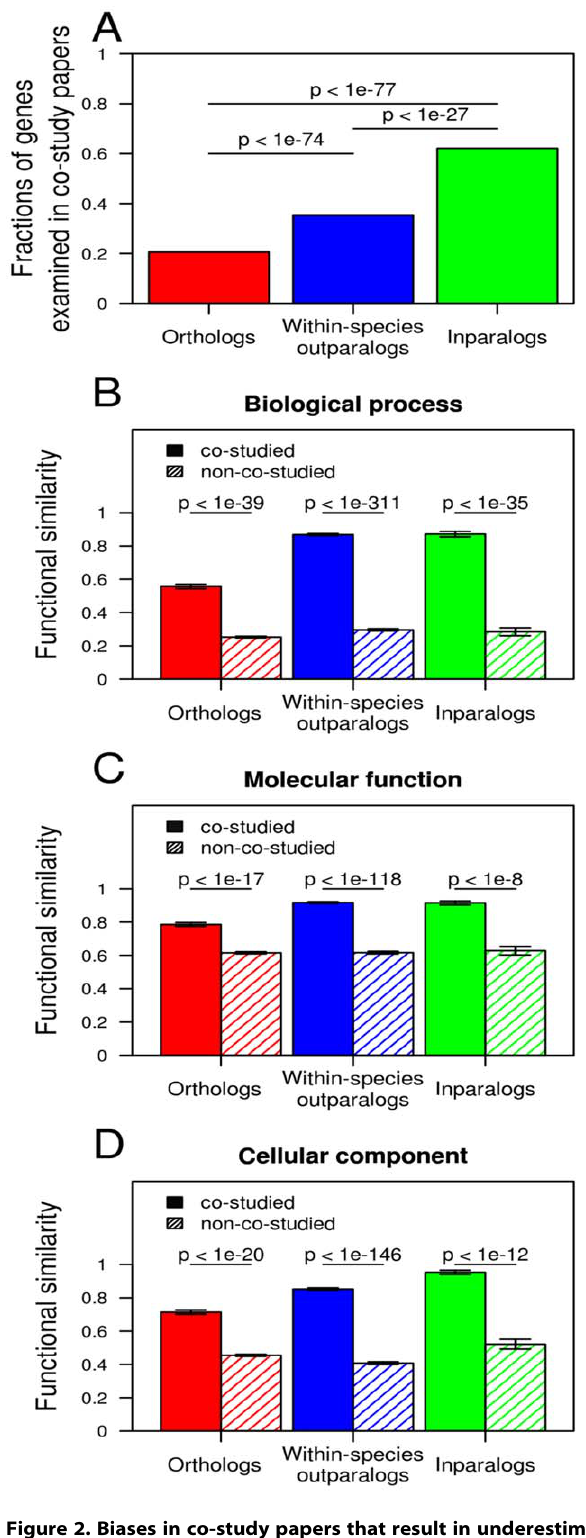
Figure 2. Biases in co-study papers that result in underestima- tion of functional similarity of ortholog, compared with paralogs. ( A ) Fractions of homologous gene pairs that have been co-examined in the same papers. P values are from a chi-square test. ( B – D ) Functional similarity of homologous genes estimated from co- study papers and other sources of data. Error bars indicate one standard error. P values are from t -tests.